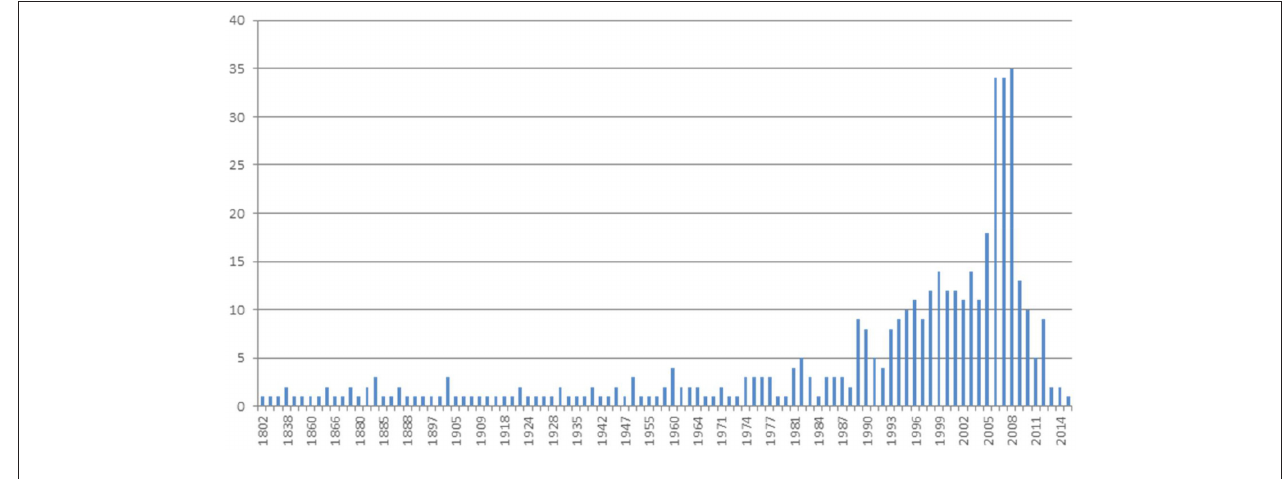
FIGURE 3 | The temporal distribution of the firms of the sample ( n = 460